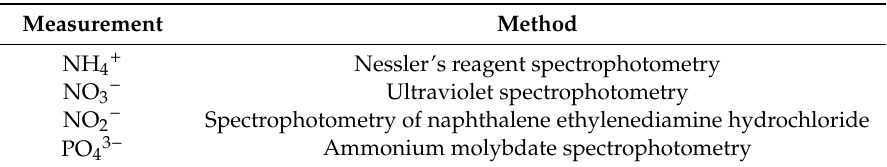
Table 3. Nation measurement standard